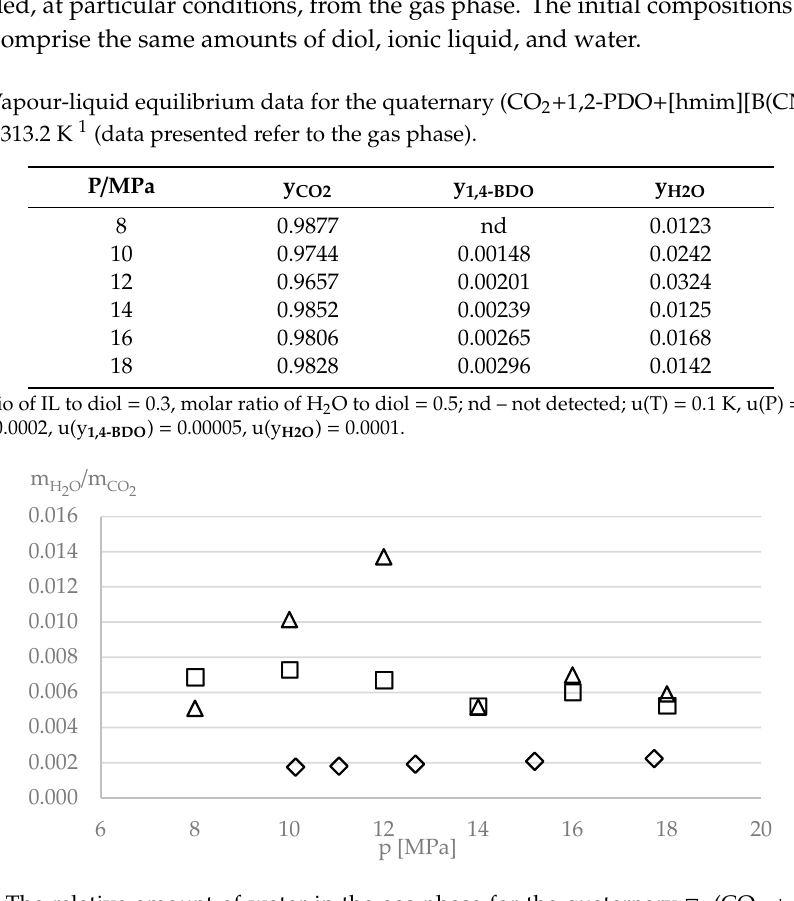
Figure 4. The relative amount of alcohol in the gas phase for the quaternary ■ , (CO 2 + 1,4-BDO +